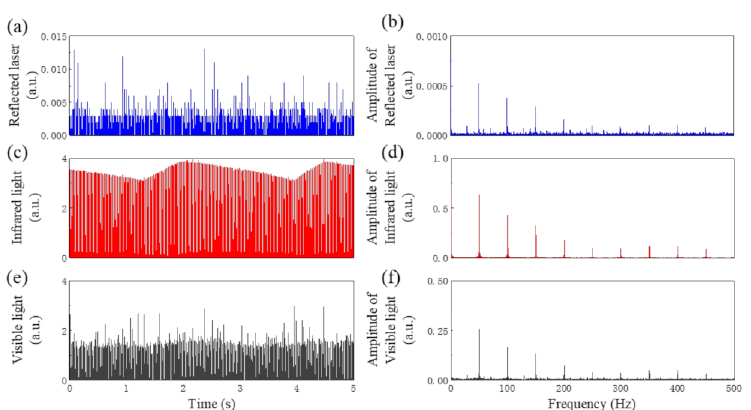
Figure 5. Noise signals of visible light, infrared light, and reflected laser in time domain and frequency domain. ( a ) noise signals of reflected laser in time domain, ( b ) noise signals of reflected laser in frequency domain, ( c ) noise signals of infrared light in time domain, ( d ) noise signals of infrared light in frequency domain, ( e ) noise signals of visible light in time domain, ( f ) noise signals of visible light in frequency domain.